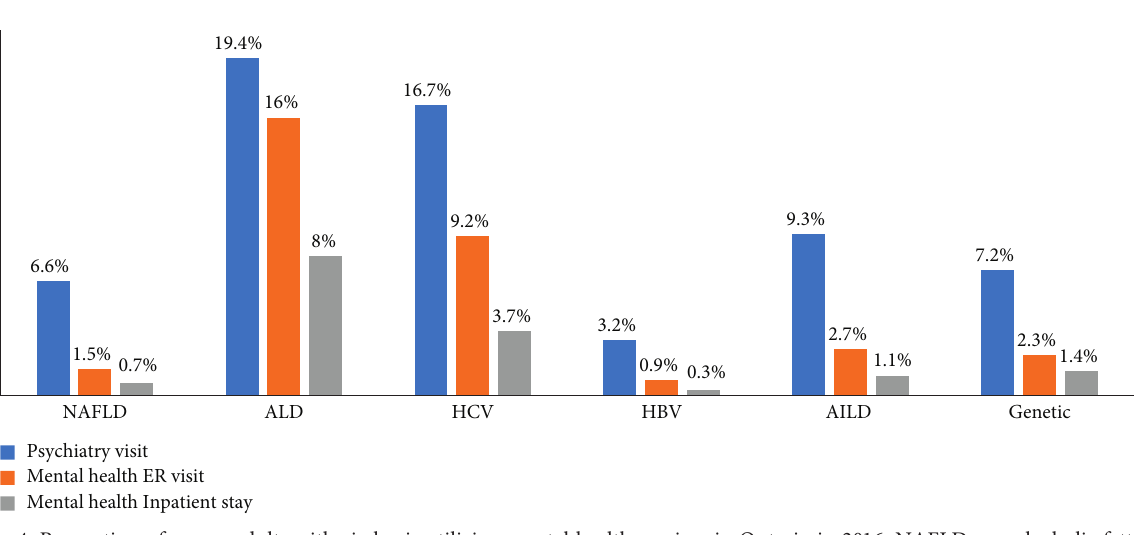
Figure 4: Proportion of young adults with cirrhosis utilizing mental health services in Ontario in 2016. NAFLD: nonalcoholic fatty liver disease; ALD: alcohol-related liver disease; HCV: hepatitis C; HBV: hepatitis B, AILD: autoimmune liver